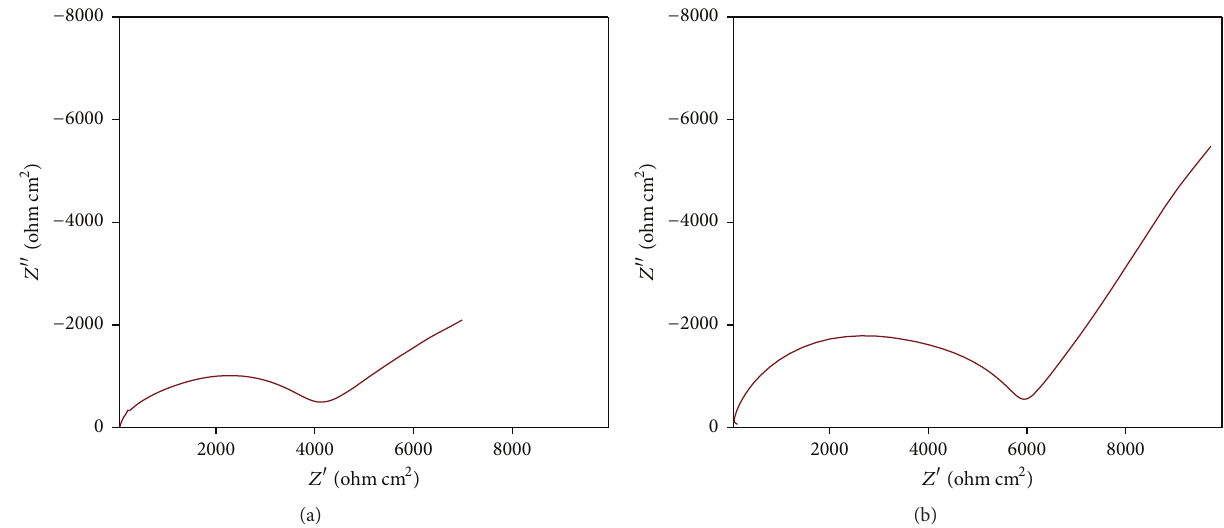
Figure 4: Impedance characteristic curves: (a) [MG49-25.0 wt.% LiClO 4 ]:[8.0 wt.% HNO 3 -THF/TiO 2 -SiO 2 ] and (b) [MG49-25.0 wt.% LiClO 4 ]:[8.0 wt.% ClHNO 2 -THF/TiO 2 -SiO 2 ] polymer electrolytes.